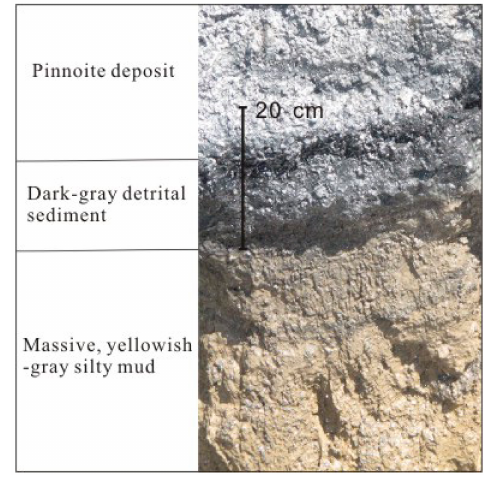
Figure 3. The basal clastic sediment of D3 section is composed of yellowish-gray lacustrine silty mud, functions as the aquifuge confining the interstitial brine in the overlying evaporitic deposit. It is overlaid by a 16-cm dark-gray layer characterized by loose and coarser detrital sediment which is then covered by pinnoite